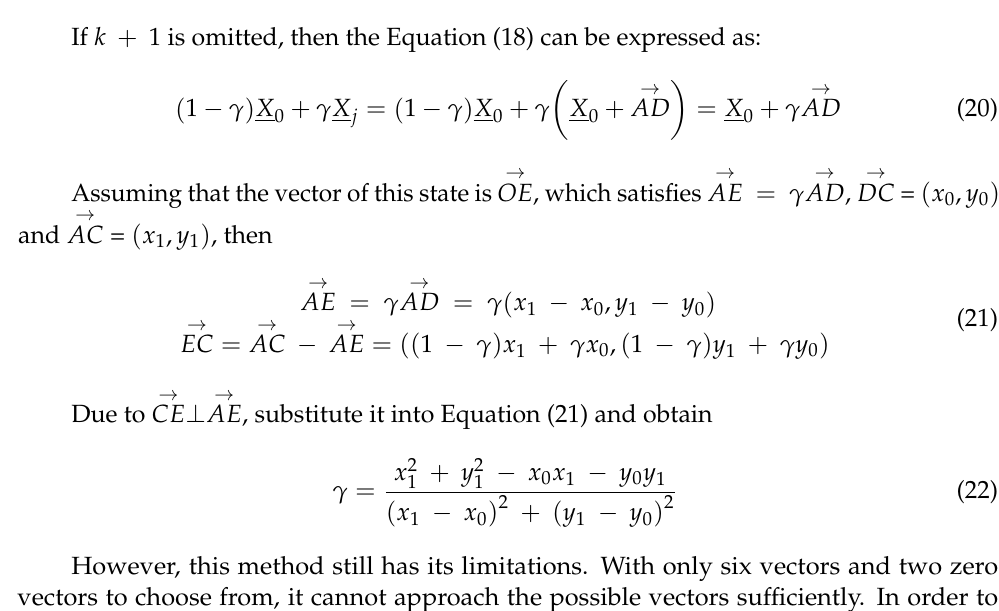
Figure 2. The solving diagram of duty cycle FCSMPC.